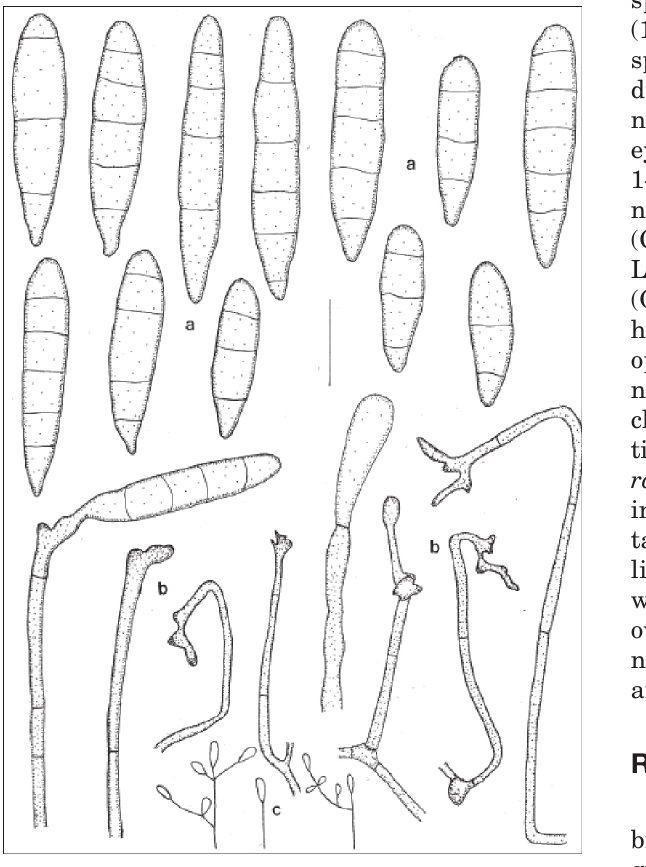
Fig. 1. Arthrobotrys multiformis : a. macroconidia; b, c. primary conidiophores. Habit sketch of conidiophore. Scale bar: a, b=25